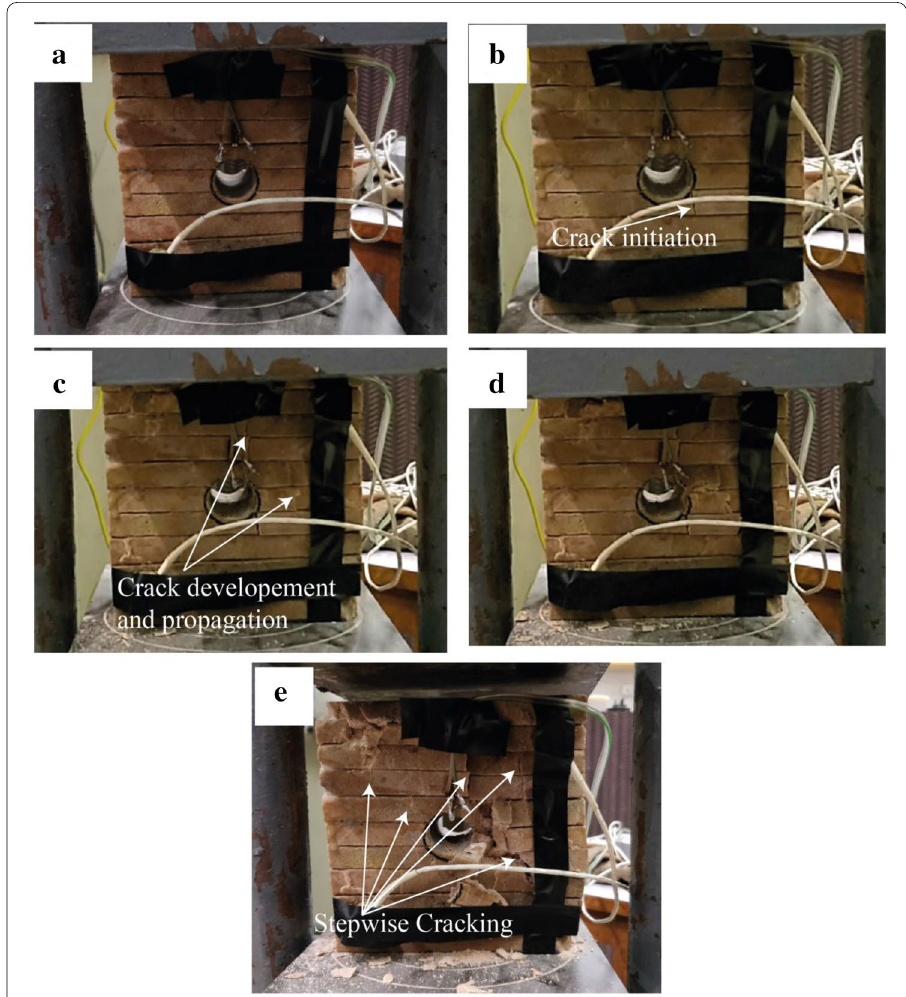
Fig. 8 Failure in sandstone block with horizontal joints, as the load is applied following failure pattern results starting from ( a – e ). a no loading is applied at this moment, b as the loading started small cracks is generated at the tunnel bottom, c , d stepwise cracking is developed and complete failure of the block as it touches the ultimate load-bearing capacity of the rock